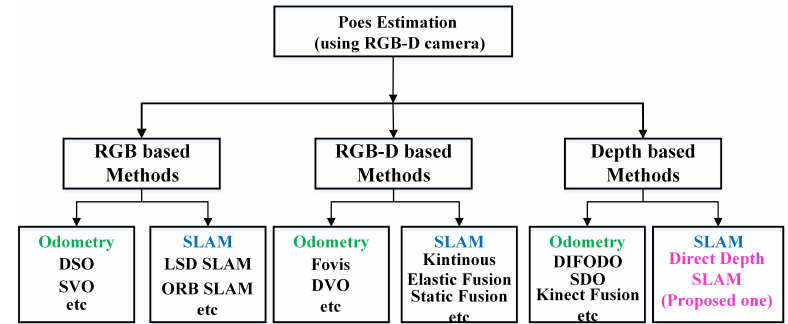
Figure 2. General classification of pose estimation methods based on an RGB-D camera (A RGB camera combined with a depth